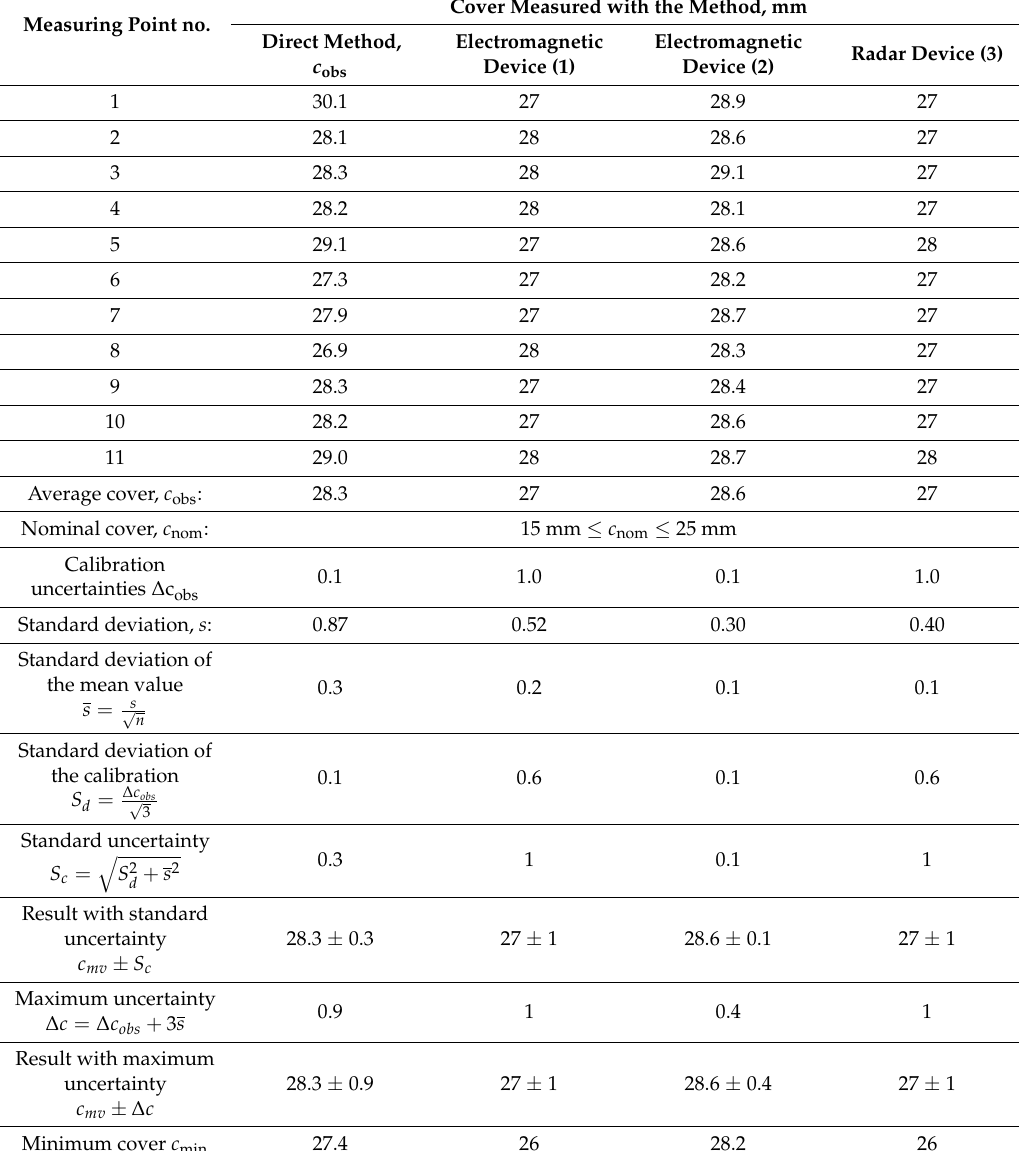
Table 1. Measurement results for stirrup reinforcement using each